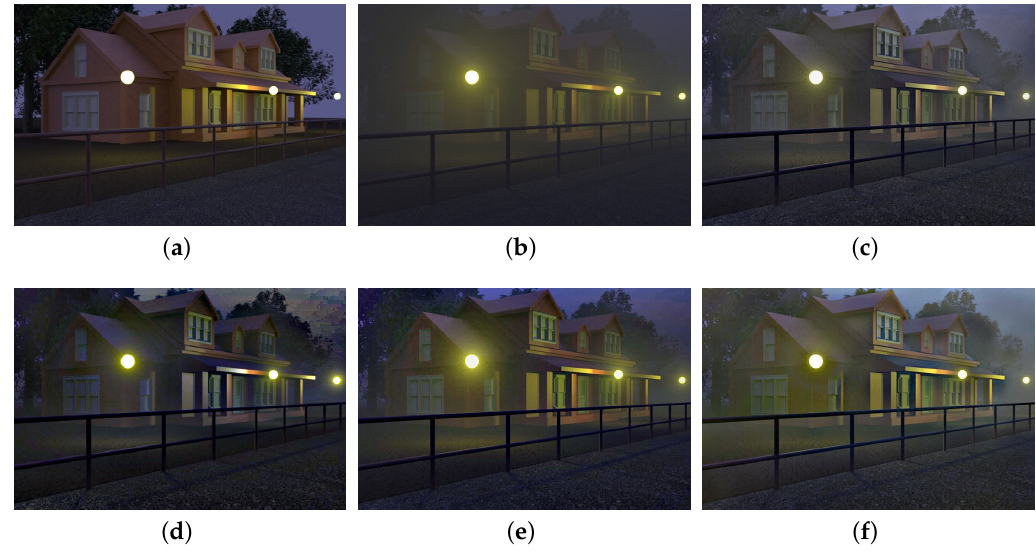
Figure 17. Comparisons on the synthetic test image. ( a ): the ground-truth image, ( b ): result of MRP